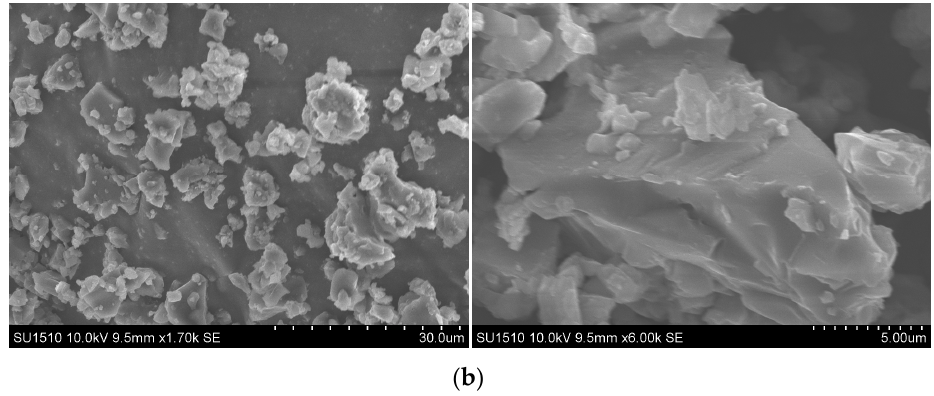
Figure 7. Scanning electron microscope image of the synthesized polyaniline. Under catalysis: ( a ) hematin ‐ MPTS ‐ M ‐ MWCNTs; ( b ) hematin ‐ MPTS ‐ M ‐ MWCNTs with addition of polyaspartic acid. Fourier transform infrared spectra for the synthesized polyaniline are shown in Figure 8. The bands at 1235/1240/1241 cm − 1 and 1292/1304/1313 cm − 1 are for C–N asymmetric stretching. The bands at 1235/1240/1241 cm − 1 result from the structure of benzenoid, and the bands at 1292/1304/1313 cm − 1 are due to the structures of quinonoid, benzenoid, and phenazine ring [27,28]. The bands at 1443/1444 cm − 1 were assigned to C=C stretching. The bands at 1499/1508 cm − l and 1569/1575/1585 cm − 1 are ascribed to benzene ring stretching and C–C stretching, respectively [27,28]. The FTIR spectra confirmed that the main structures of the synthesized polyaniline are similar for the three cases.